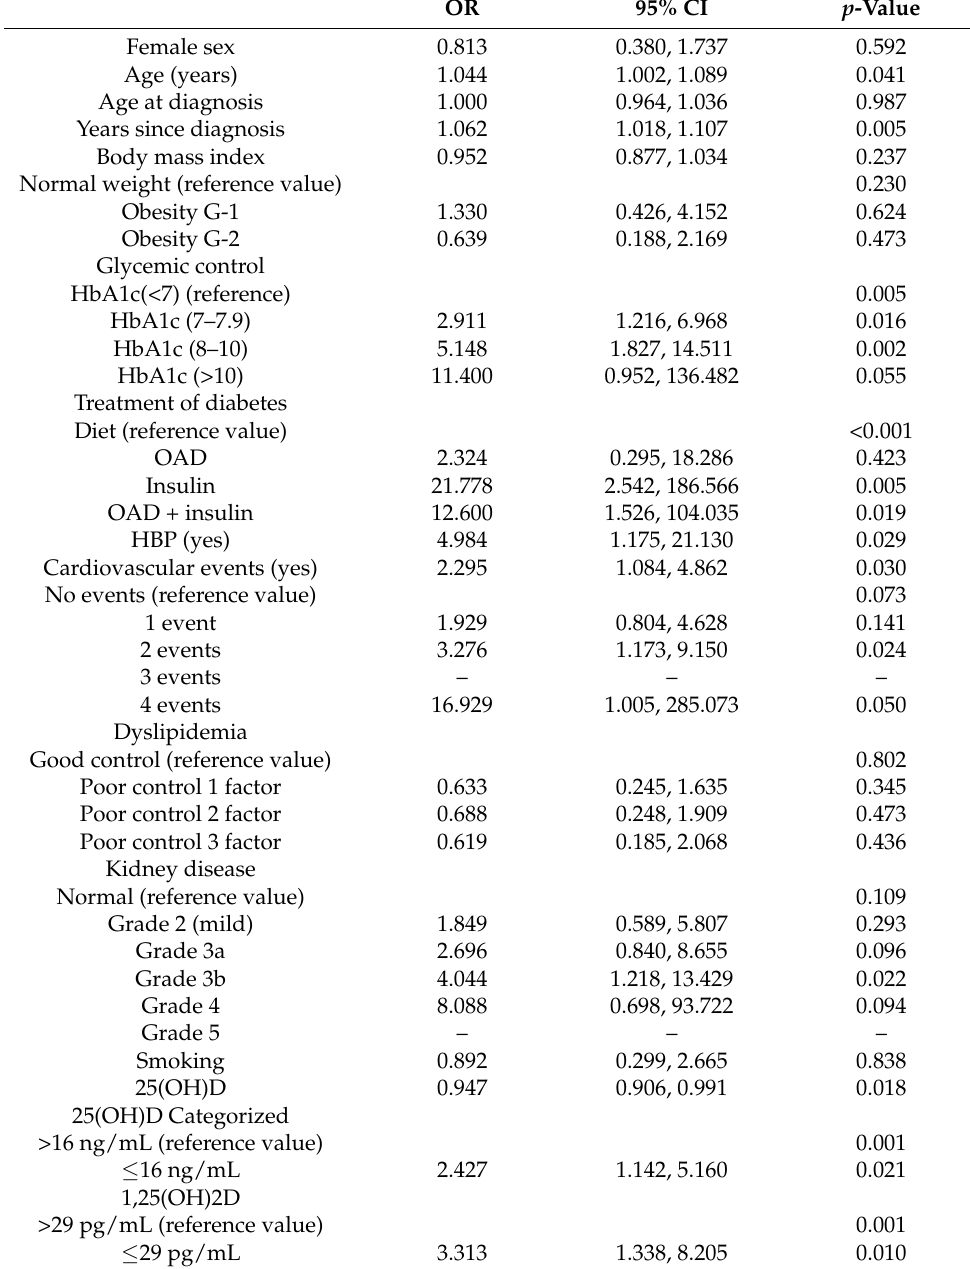
Table 2. Univariate analysis of risk factors.